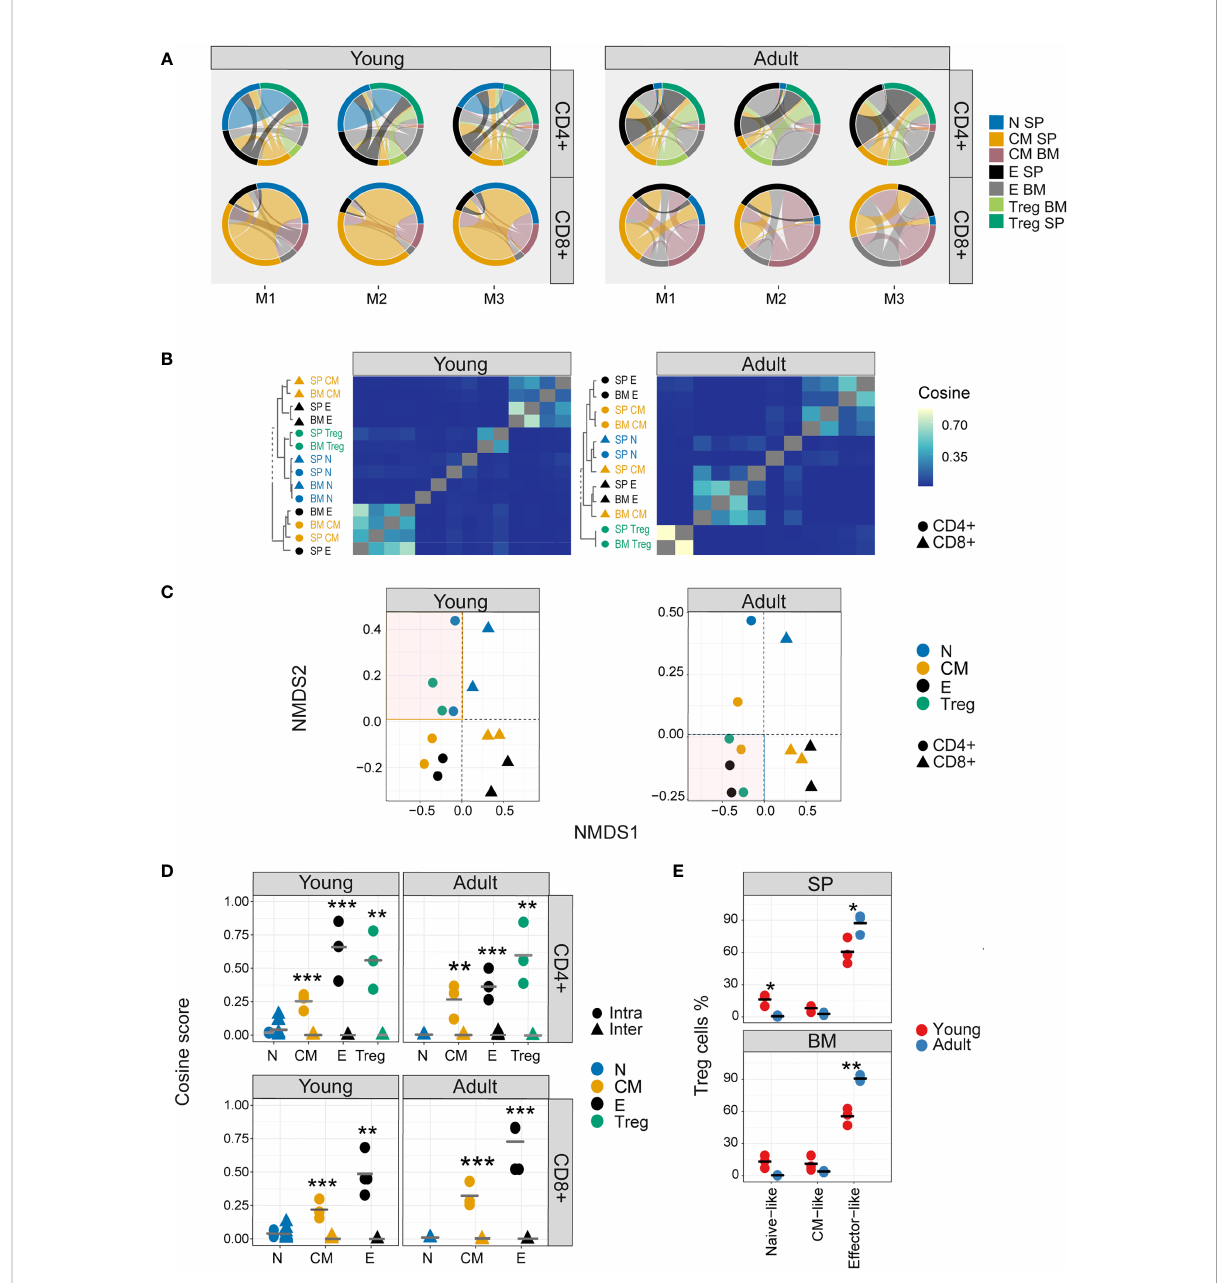
FIGURE 3 Nucleotide sequence sharing patterns differ between T cell sub-compartments. (A) Each circus plot represents a single mouse CD4+ or CD8+ compartment (upper and lower panel, respectively). Circus sharing levels illustrate the number of clones shared between two compartments (band widths), and the proportion of shared clones attributed to each compartment (circus arcs). Only sequences shared by at least two compartments were included in the analysis. (B) Pairwise cosine similarity of the CDR3 b NT sequences from representative young and adult mouse repertoires. Correlation levels are represented by color (high=light blue, low= dark blue). In color and text, hierarchical clustering dendrograms for all T cell compartments are plotted to the left of each heatmap (CD4+=circle, CD8+= triangles). (C) The similarity matrices shown as heatmaps in B are represented in two dimensions by NMDS. (D) Cosine similarity between CDR3NT b chains across (triangles) and within individuals (between spleen and bone marrow, circles). T cells compartments (colored dots) are divided to CD4+ (upper) and CD8+ (lower) from young (left) and adult (right) mice repertories. Mean is shown by horizontal black lines. (E) The surface phenotype of Foxp3+ Tregs. The plot shows the percentage of Foxp3 positive cells (Treg) which have the phenotype: CD44- CD62L+ (naive-like), CD44+CD62L+ (central memory -like) or and CD44+CD62L- (effector-like). Mean is shown by horizontal black lines. Each data point represents one mouse. Signi fi cant differences between age groups or intra and inter individuals are denoted by asterisks (P-values: *<0.05, **< 0.01, ***< 0.001, with FDR correction